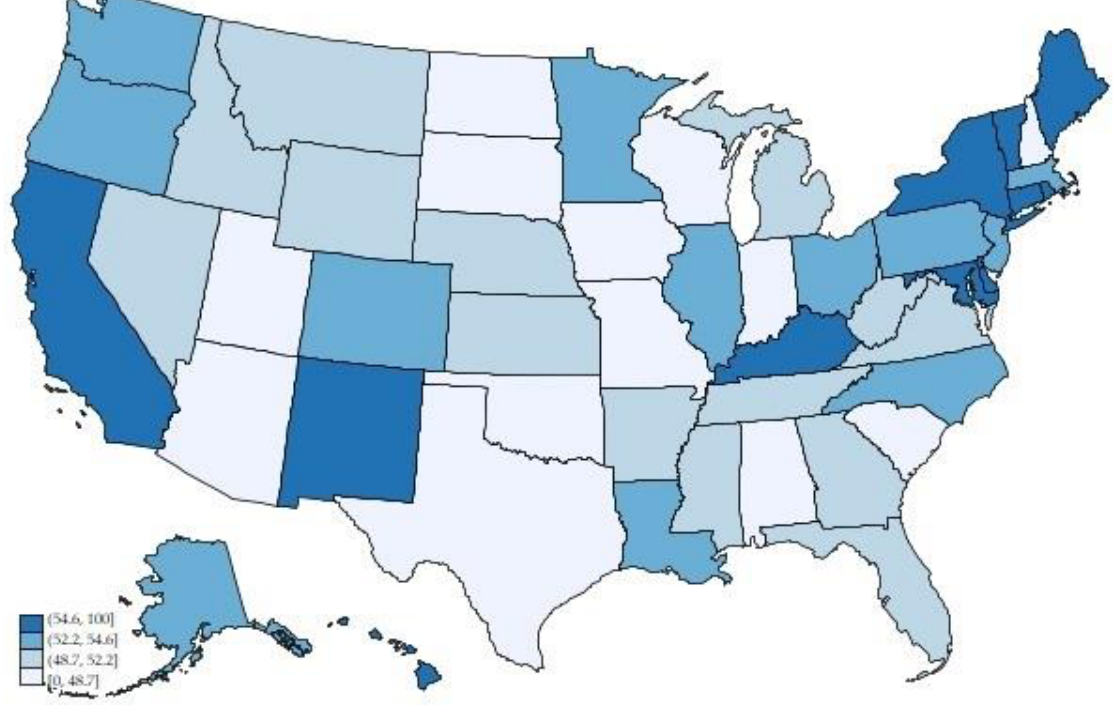
Figure 2. United States: Stringency Index by state (2020 average, Source: Our World in Data).